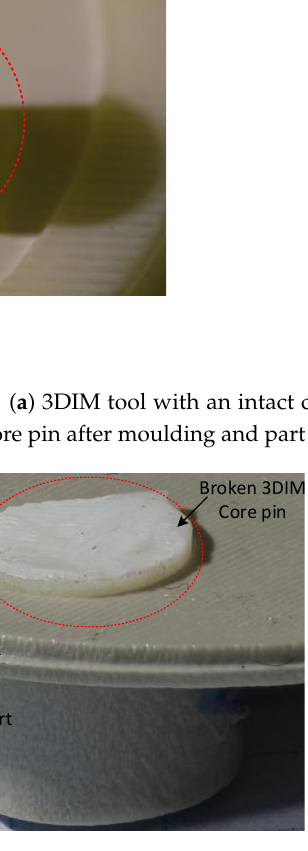
Figure 20. M5 core pin on the 3DIM tool broken and stuck inside the part during ejection. (White coloured material is the tool and grey coloured material is the